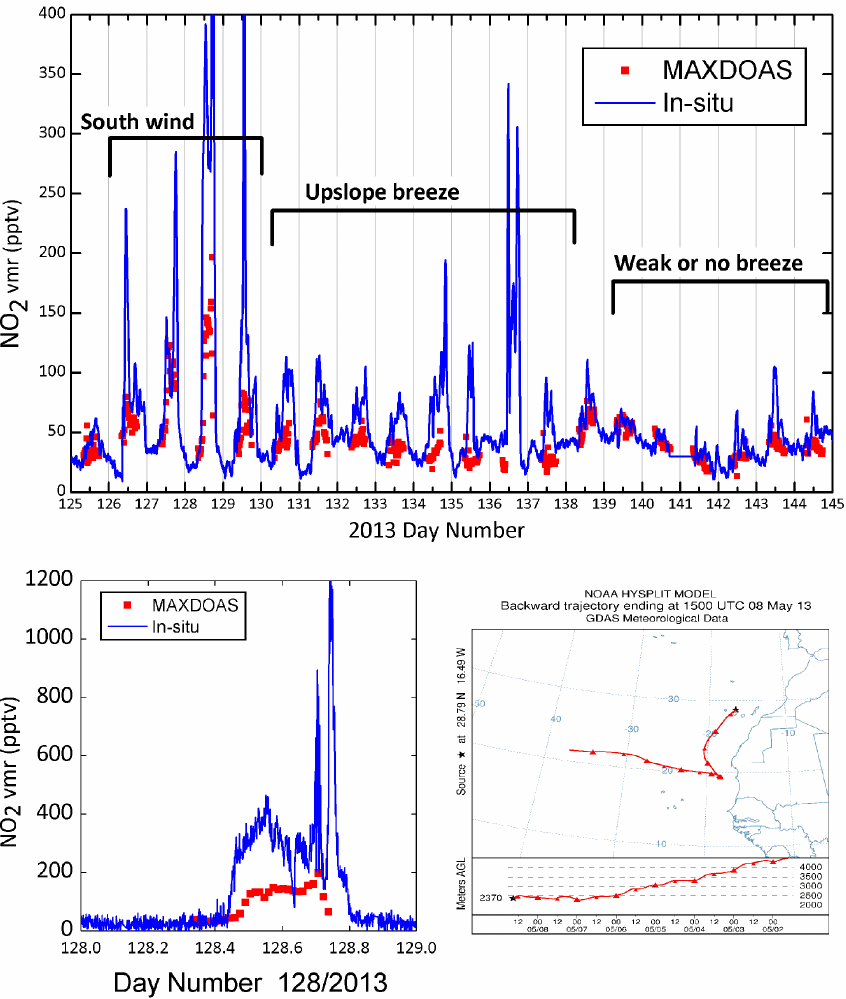
Figure 3. In situ NO 2 volume mixing ratio measurements made every minute versus Izaña MAXDOAS, for a period of time representative of three different wind situations. In situ data are smoothed by 50min running mean (top panel). An expanded plot is shown for 8 May 2013 (day number 128). A back trajectory ending at Izaña at 15h of the same day is